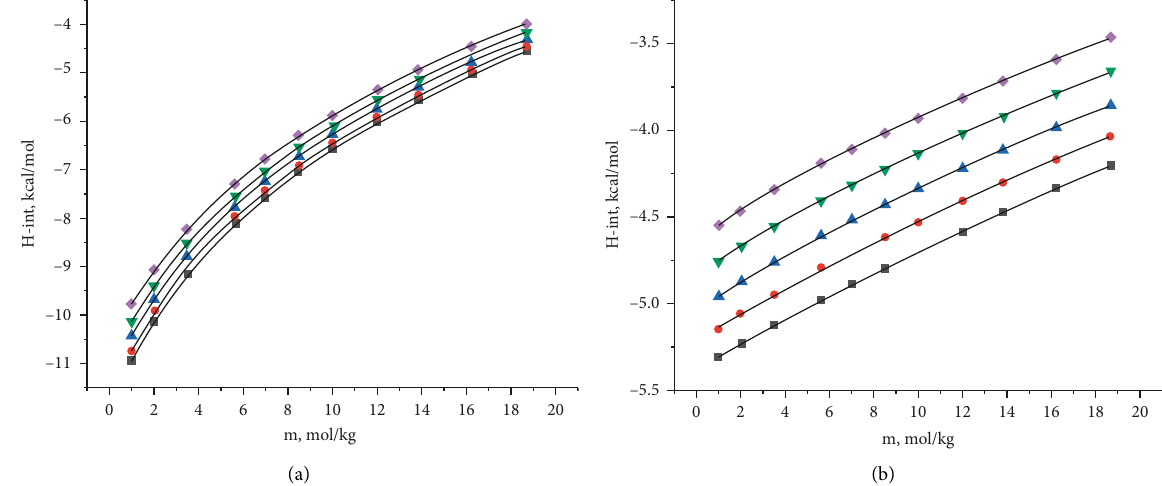
Figure 7: Correlation of the interaction data for the LiCl+H ( , T � 303.15K;